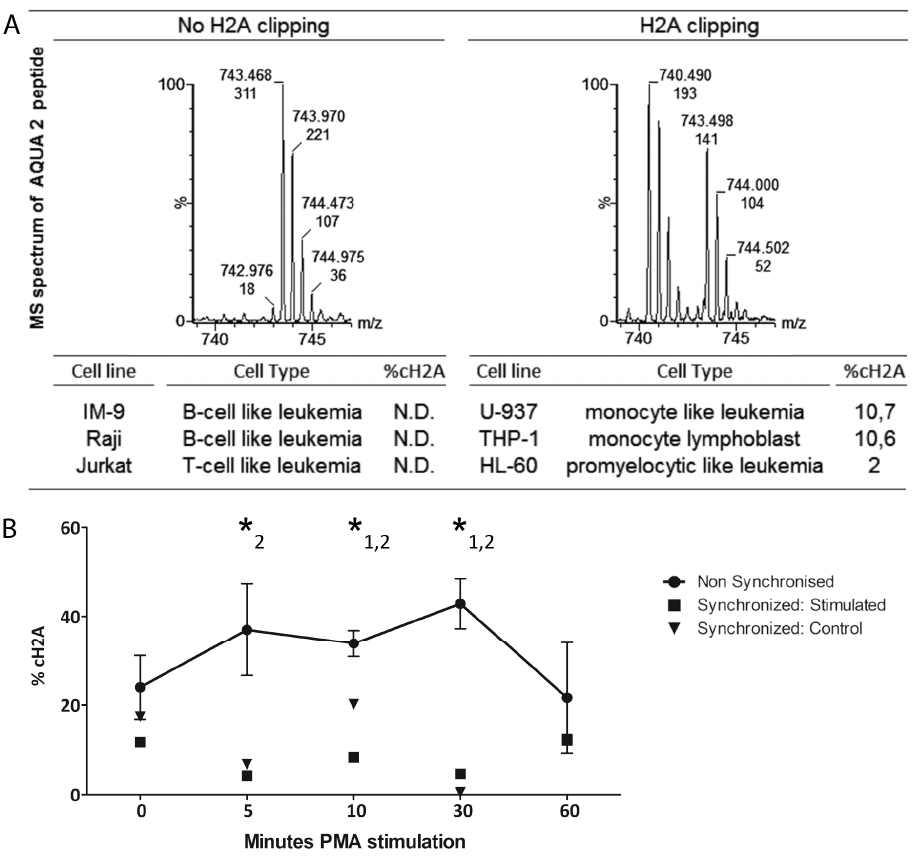
Figure 3. Specific cH2A quantitation in myeloid cell lines. ( A ) Example of an MS spectrum of the AQUA 2 peptide if H2A V clipping is absent ( left ) or present ( right ). 114 The analysis of different cell lines confirms the myeloid characteristic of cH2A in the U-937, THP-1 and HL-60 cells. H2A clipping is not present in the investigated lymphatic cell lines and could not be unambiguously detected in the promyelocytic HL-60 cell line; ( B ) THP-1 cells stimulated with PMA show a transient H2A clipping pattern. Three biological replicates display the high variance. * 1: significant differences of %cH2A between T and the other data points; * 2: the equivalent for T . The %cH2A of PMA0 PMA60 synchronized stimulated and control THP-1 cells, presented respectively as squares and triangles, is lower than the %cH2A of non-synchronized